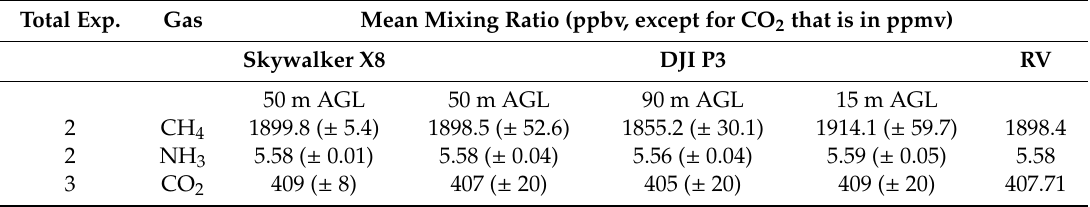
Table 1. Reproducibility analysis and comparison to reference values